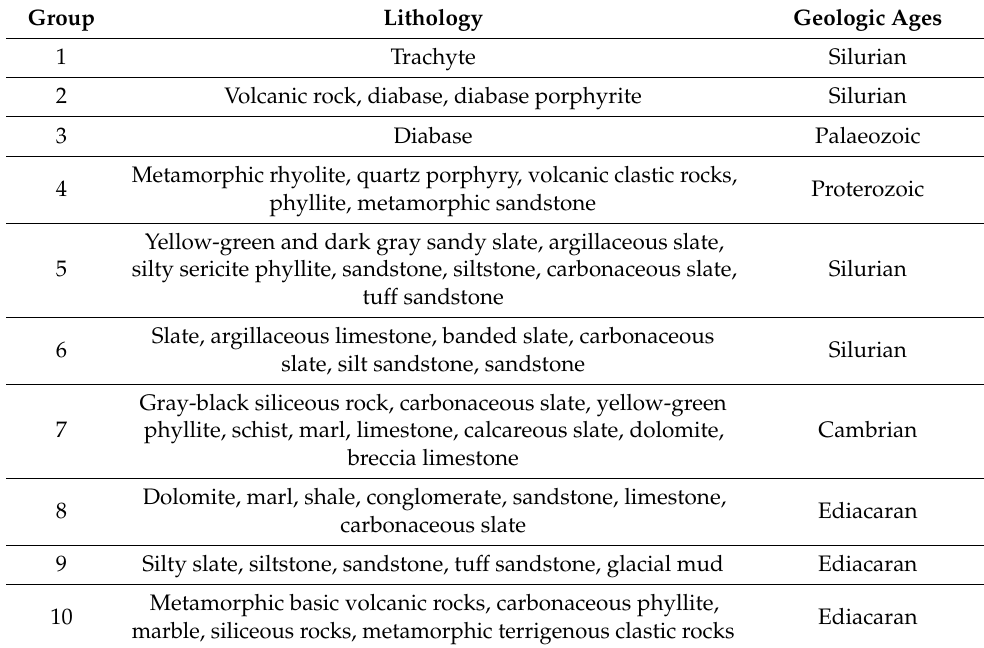
Table 1. Description of the lithological units. Group Lithology Geologic